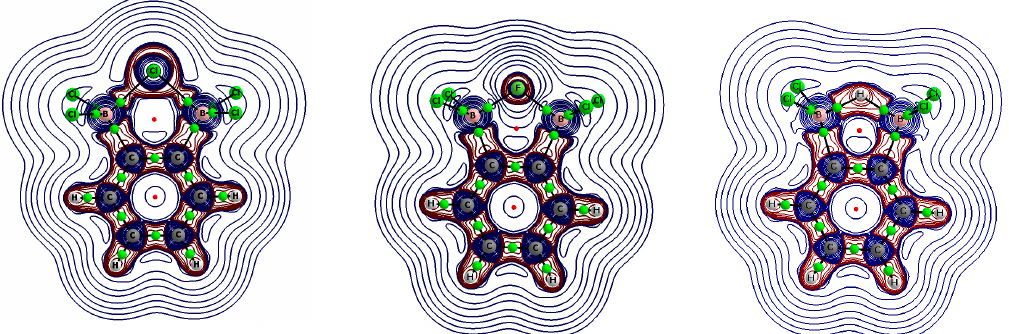
Figure 3. Molecular graphs of the anionic 1,2-bis(dichloroboryl)benzene complexes (chloride, fluoride, and hydride, from left to right, respectively); solid lines correspond to bond paths, big circles to attractors and small circles to critical points; the isolines of the Laplacians of electron density are also presented: positive values are depicted in blue lines and negative values in brown lines.